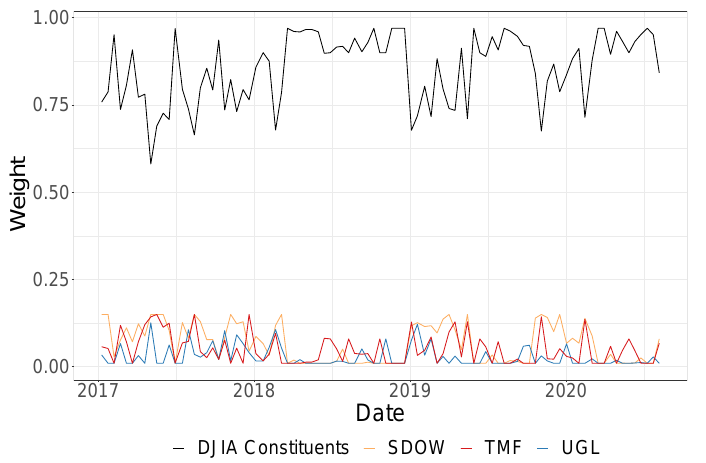
Figure 4. Allocation: this figure plots the weights of 0-CDaR optimal portfolio on DJIA constituents and 3